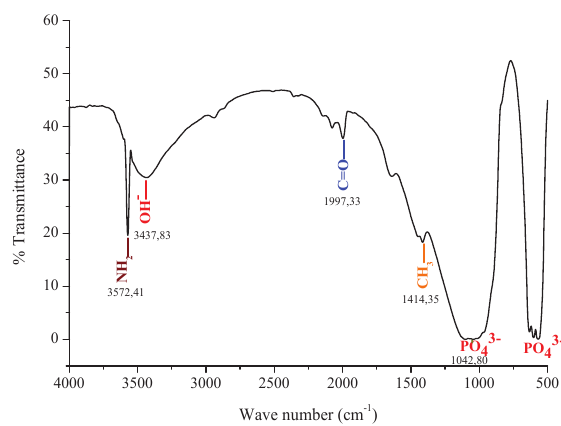
Figure 7: FTIR spectra of collagen grafted HA sample.